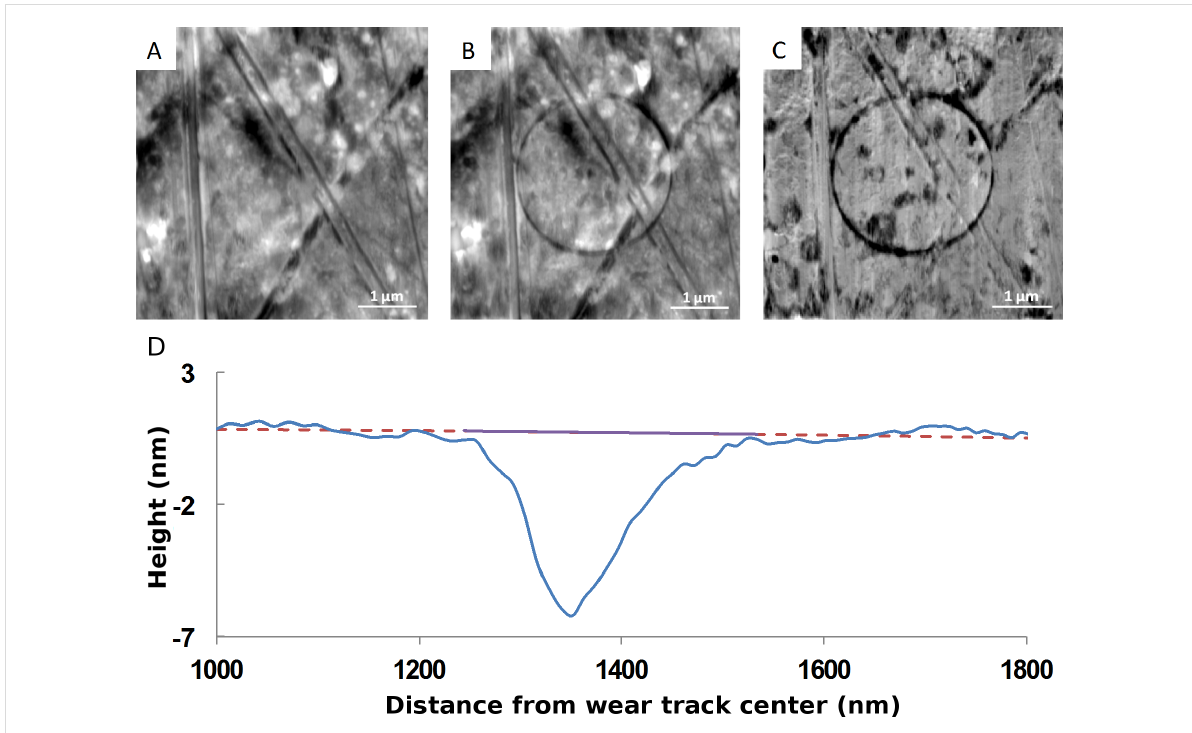
Figure 3: Summary of the steps for computing the wear volume from AFM topographic images (image size: 5 × 5 µm): A and B (grey scale is 35 nm) and B shows the AFM topographic images, before and after wear respectively, for a given location on a copper-based composite (the counter-body is a silicon nitride probe); C (grey scale is 16 nm) is the height difference of the topographic images (B) − (A). The drift correction has been previously determined; the bottom image D is the average height as a function of the distance from the center of the wear track circle. The baseline (dotted red line) in this example is obtained by a polynomial fit of order 4 of the profile without considering the wear track. The wear volume is calculated by inte- grating the surface under the full purple line.